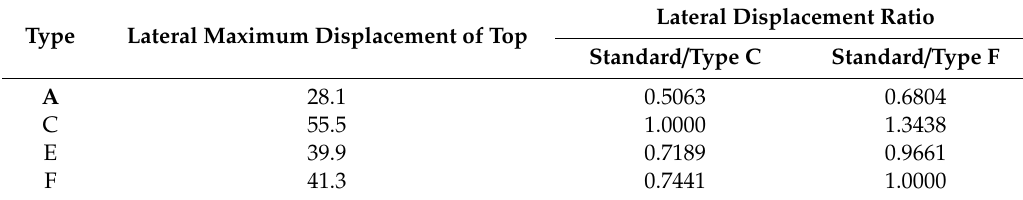
Table 9. Lateral displacement ratio according to installation interval of back